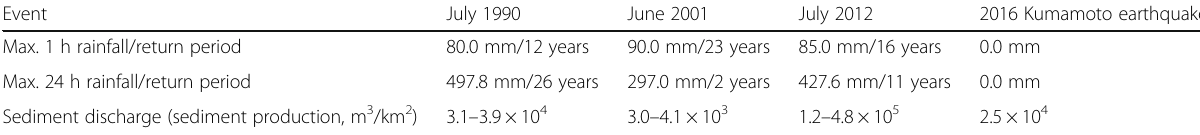
Table 2 Comparison of sediment discharge and production triggered by the heavy rainfall events in 1990, 2001, and 2012 (after Miyabuchi and Daimaru, 2004 and Saito et al. 2016), and the 2016 Kumamoto earthquake. The rainfalls and return periods were calculated from radar/rain-gauge analyzed precipitation provided by the Japan Meteorological Agency (Saito and Matsuyama,